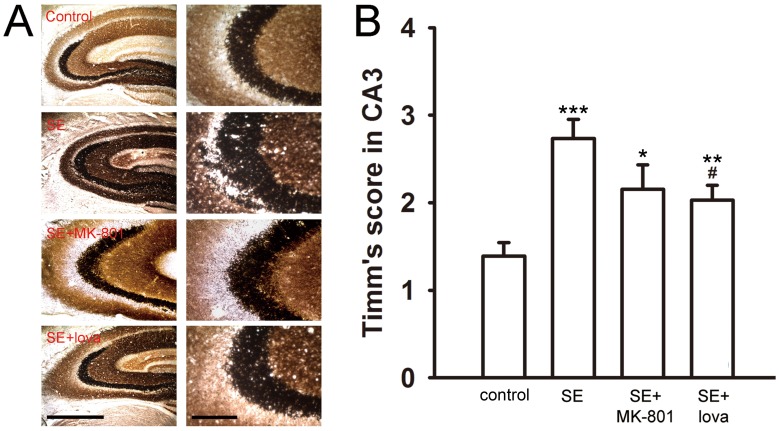
Timm’s stain under different treatments in the CA3.(A) The Timm’s score was significantly increased after SE induction. MK-801 and lovastatin significantly decreased Timm’s score after SE induction. Scale bar, 200 µm in the left panels and 100 µm for the right panels. (B) Summary data showing the mean Timm’s score between control and experimental groups in the CA3. (*compared with control group; #compared with SE group).